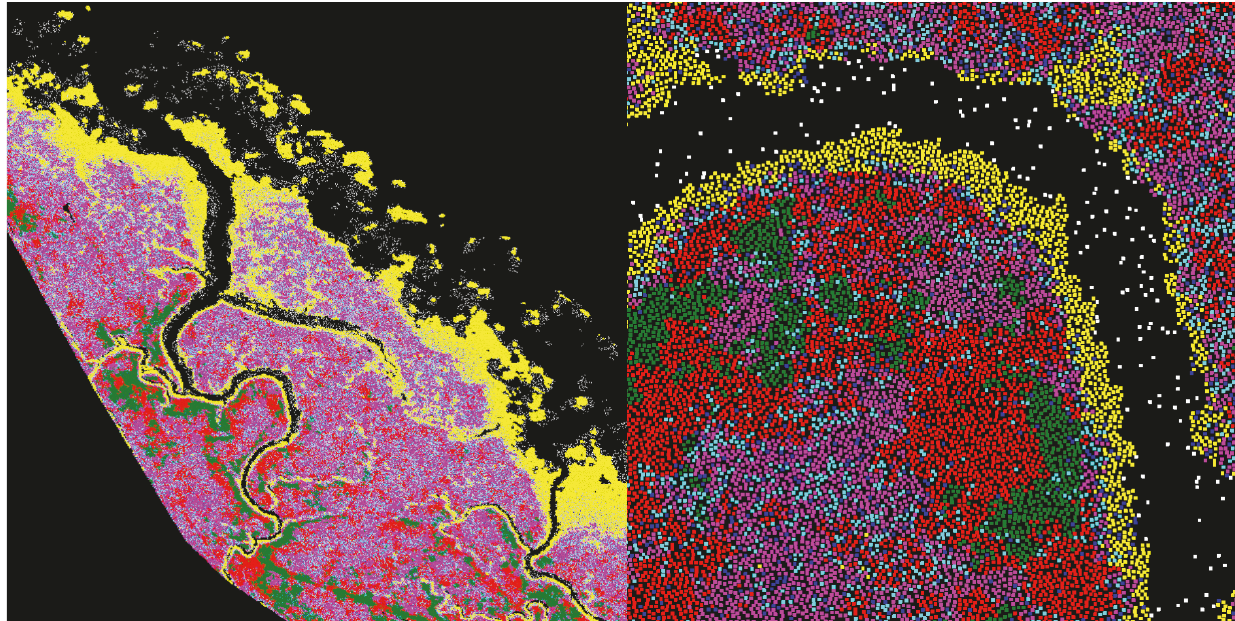
Figure 13: Result of the vegetation model for the Paulinapolder where yellow is Spartina, green is Elymus, red is Atriplex, blue is Aster, teal is Artemisia, pink is Limonium, and white is Salicornia.